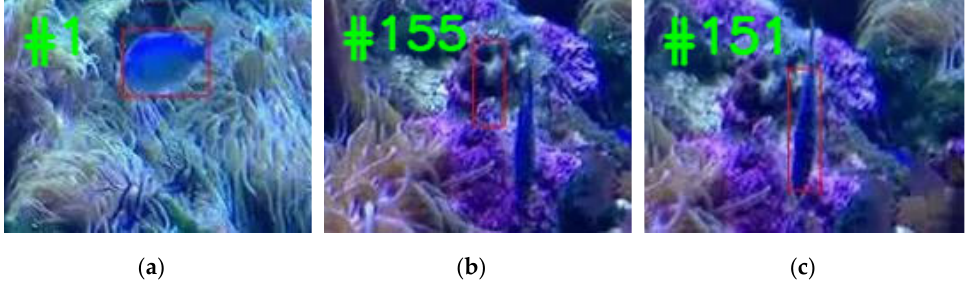
Figure 7. Dynamic template set update. ( a ) shows the original template of the tracking process; ( b ) shows the scene where the appearance of the target has changed; ( c ) shows the updated template.